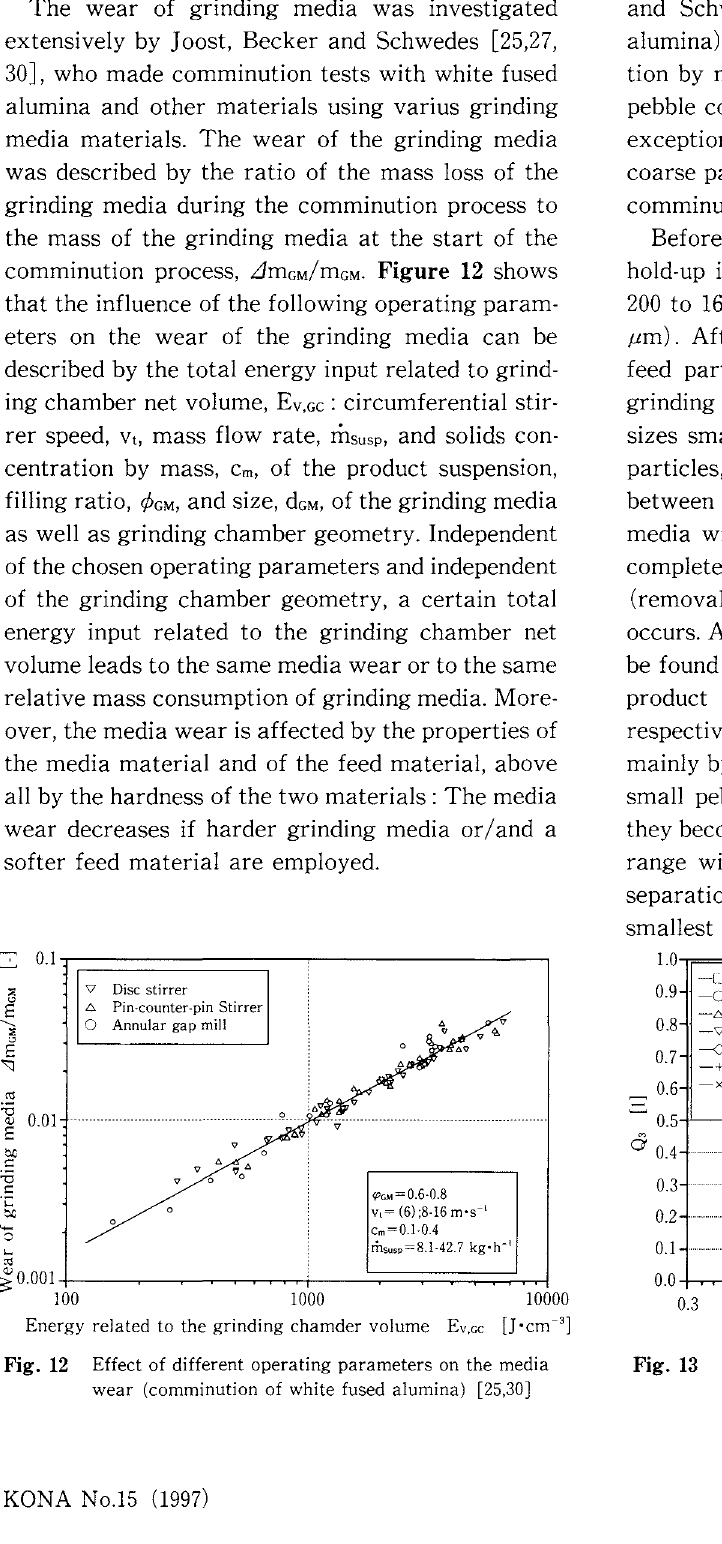
Fig. 12 Effect of different operating parameters on the media wear (comminution of white fused alumina) [25,30]